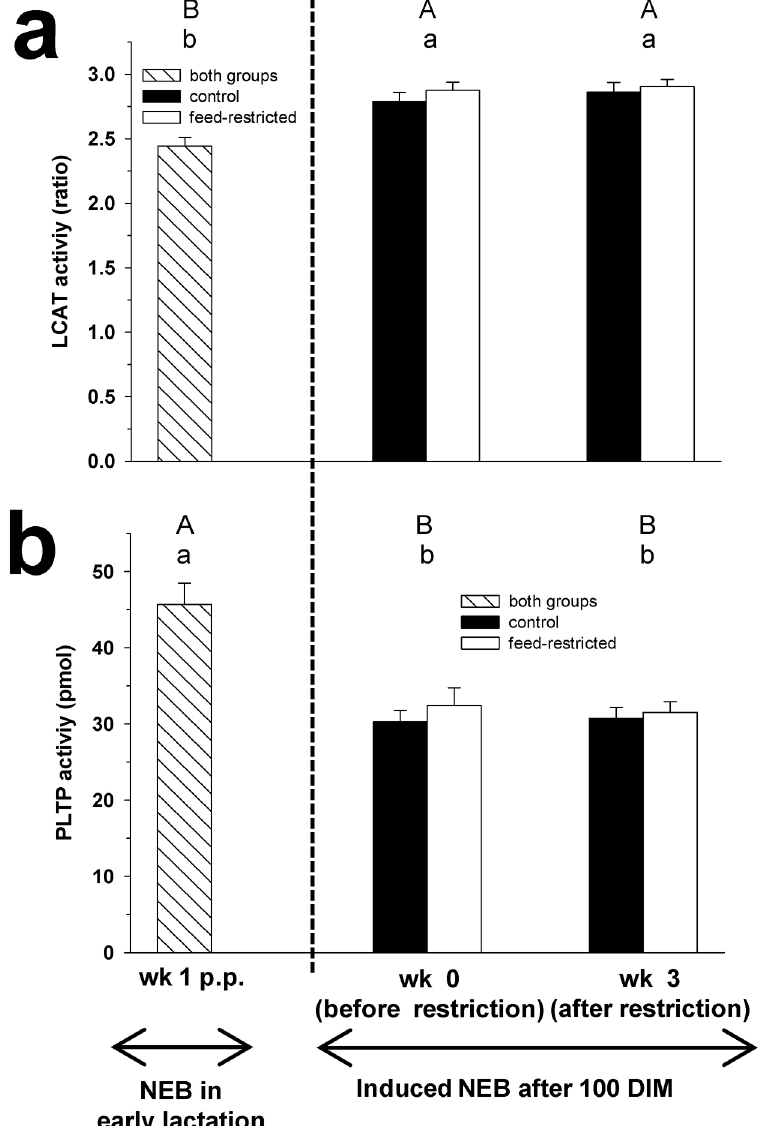
Fig 4. LCAT and PLTP activities. Plasma activity of lecithin:cholesterol acyltranserase (LCAT; Fig 4a) and phospholipid transfer protein (PLPT; Fig 4b) in week 1 p.p., and before (week 0) and after (week 3) feed restriction in mid-lactation. Changes over time within the groups are marked with superscripts (A and B for the control group (CON); a and b for the feed-restricted group (RES); P < 0.05). Data are presented as means ± standard error of the